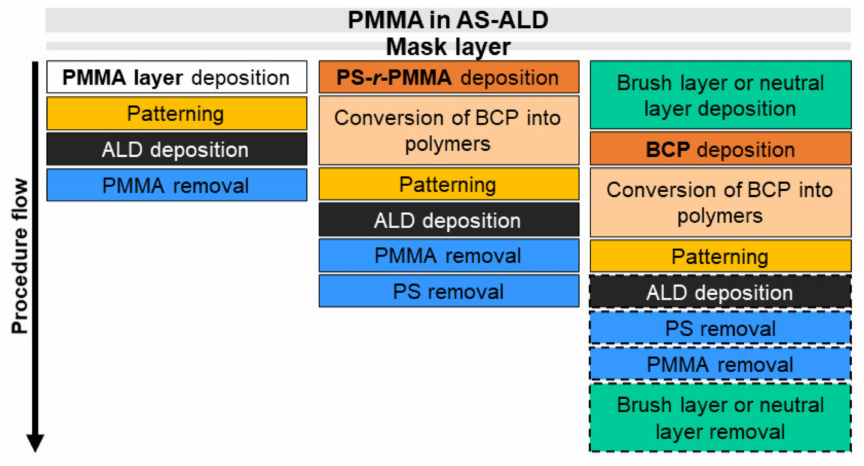
Figure 21. PMMA in an AS-ALD process, where the block copolymers are polystyrene- random- poly(methylmethacrylate) (PS- r -PMMA) or polystyrene- block -poly(methylmethacrylate) (PS- b